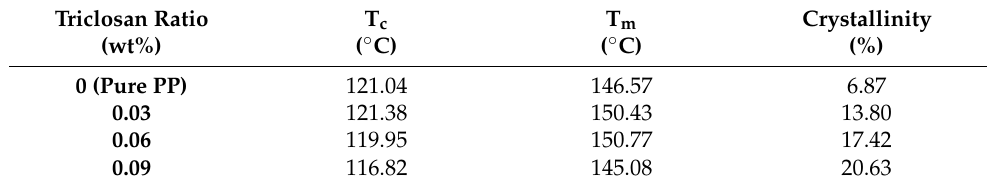
Table 1. Thermal properties of antibacterial electret PP filters as related to the triclosan amount being 0.03, 0.06, and 0.09 wt%.